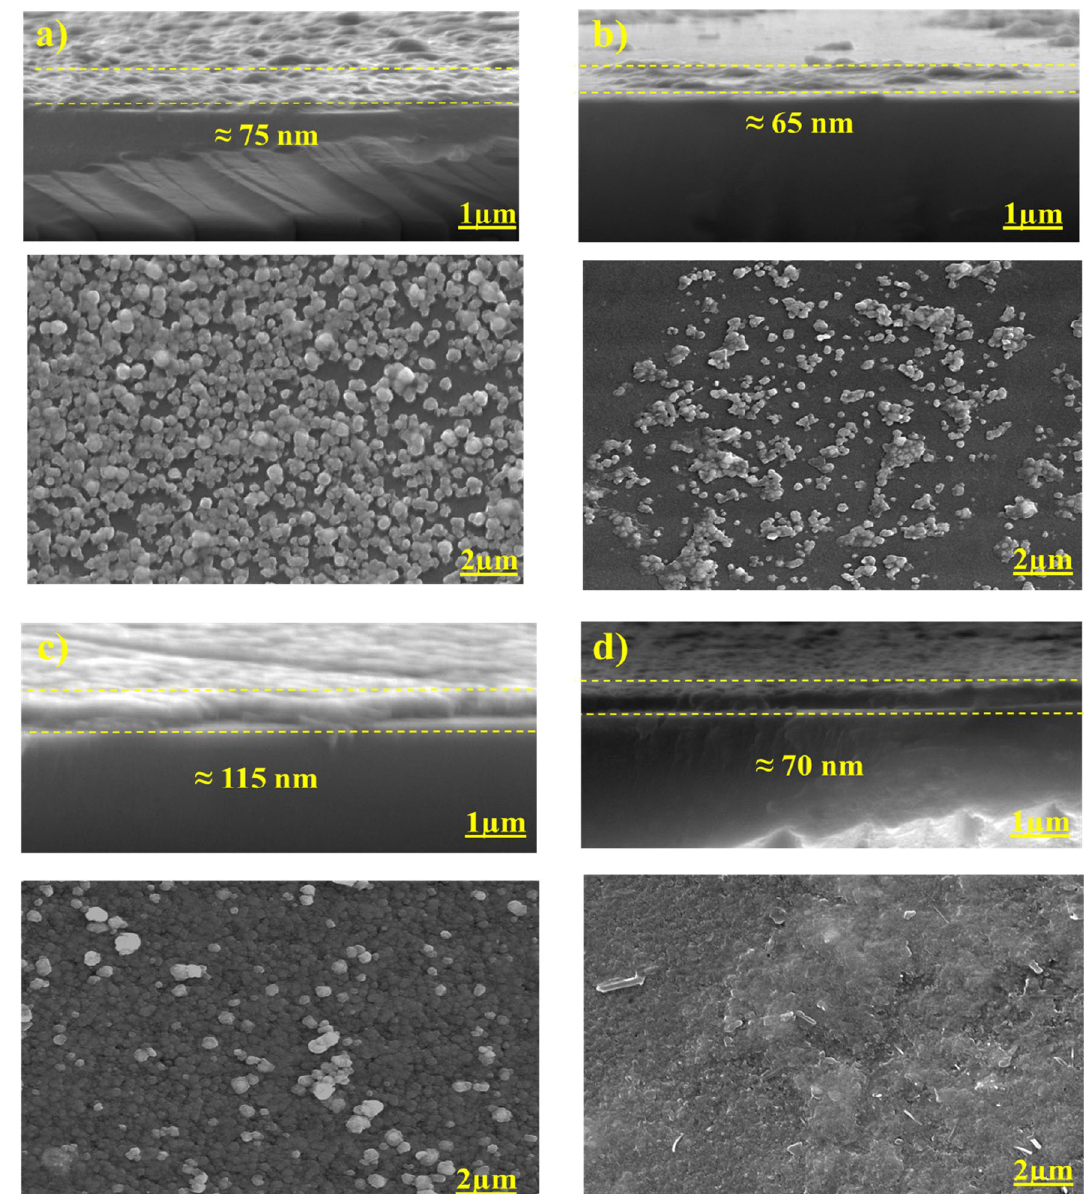
Figure 5. FESEM images of the top and cross-sectional view of; ( a ) CdS, ( b ) CdS + Ag, ( c ) CdS + MPA, ( d ) CdS + Ag +